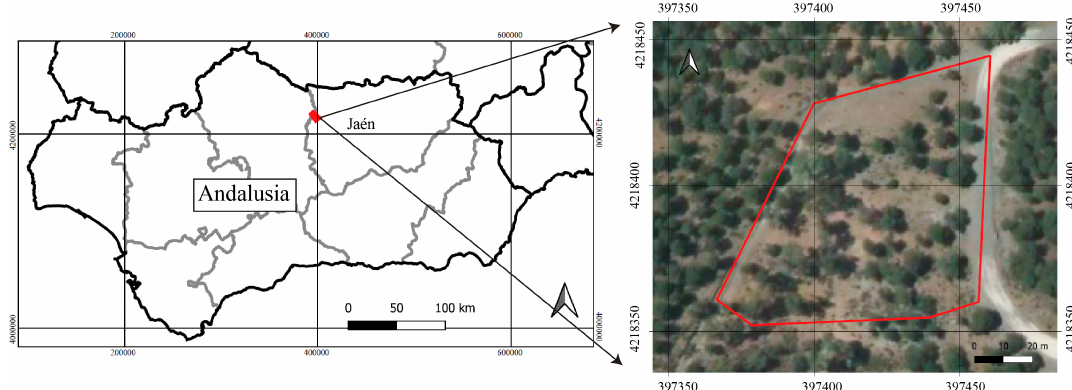
Figure 1. Research area. The left image represents the south of Spain (Andalusia). The right image is the map of the observed forest in Jaén. The coordinates (m) are UTM, zone 30 referred to